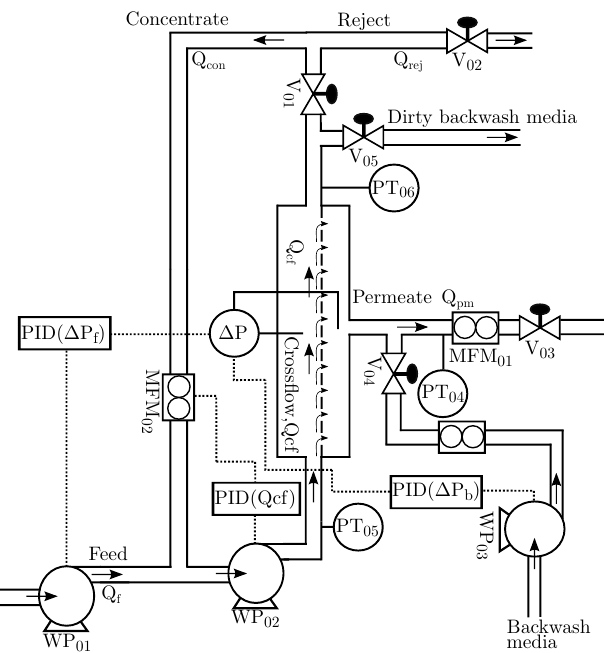
Figure 1. Piping and instrumentation diagram, where the syntax PID( Q cf ) means that Q cf is the controlled variable, where ∆ P f and ∆ P b are the TMP references during filtration and